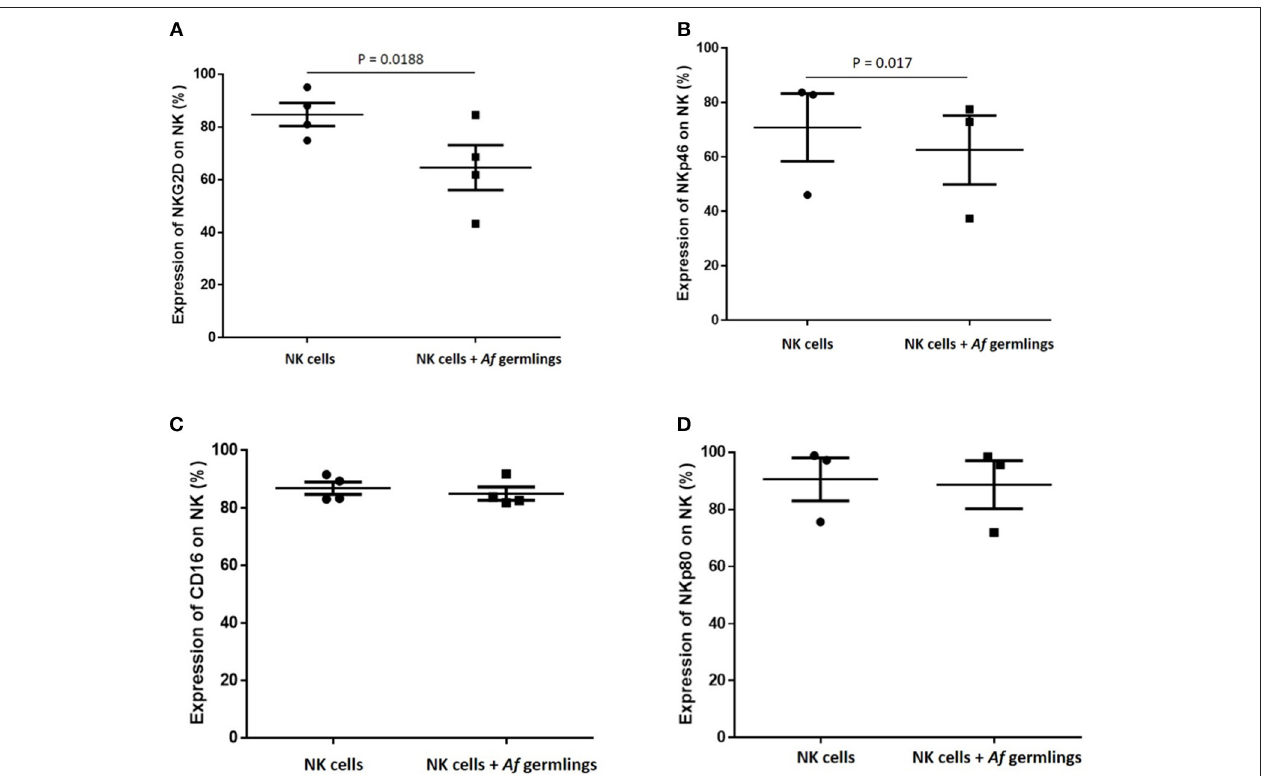
FIGURE 5 | NK cell challenge with A. fumigatus reduces surface expression of the activatory receptors NKG2D and NKp46 (A) . NKG2D NK cell surface expression is reduced by A. fumigatus . Human NK cells were incubated overnight with A. fumigatus germlings at MOI = 0.05. NKG2D expression was determined by FACS, gating live NK cells. Statistical analysis was performed using the Student’s paired t -test. n = 4 (B) . NKp46 NK cell surface expression is reduced by A. fumigatus . Human NK cells were incubated overnight with A. fumigatus germlings at MOI = 0.05. NKp46 expression was determined by FACS, gating live NK cells. Statistical analysis was performed using the Student’s paired t -test. n = 3 (C) . CD16 expression on NK cells surface is not altered in the presence of A. fumigatus . Human NK cells were incubated overnight with A. fumigatus germlings at MOI = 0.05. CD16 expression was determined by FACS, gating live NK cells. Statistical analysis was performed using the Student’s paired t -test. n = 4 (D) . NKp80 expression on NK cells surface is not altered in the presence of A. fumigatus . Human NK cells were incubated overnight with A. fumigatus germlings at MOI = 0.05. NKp80 expression was determined by FACS, gating live NK cells. Statistical analysis was performed using the Student’s paired t -test. n =